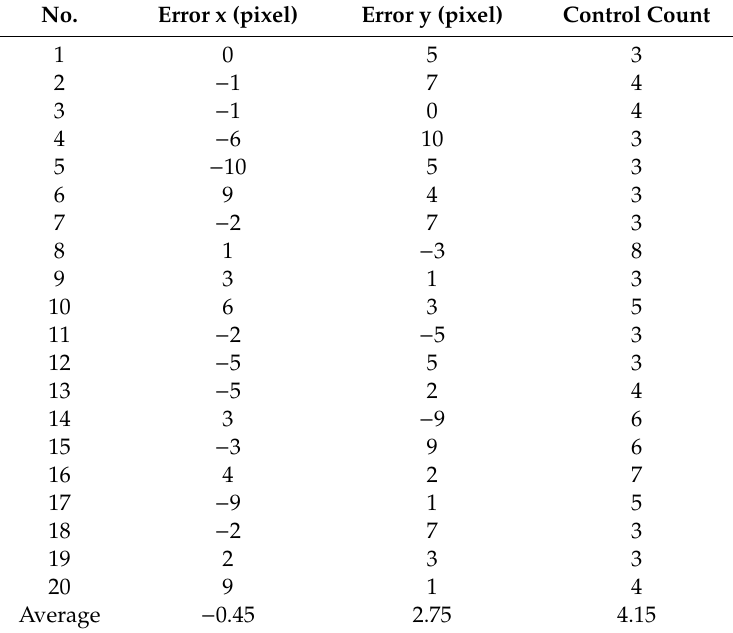
Table 2. Test results of a sweet pepper’s position controlling.